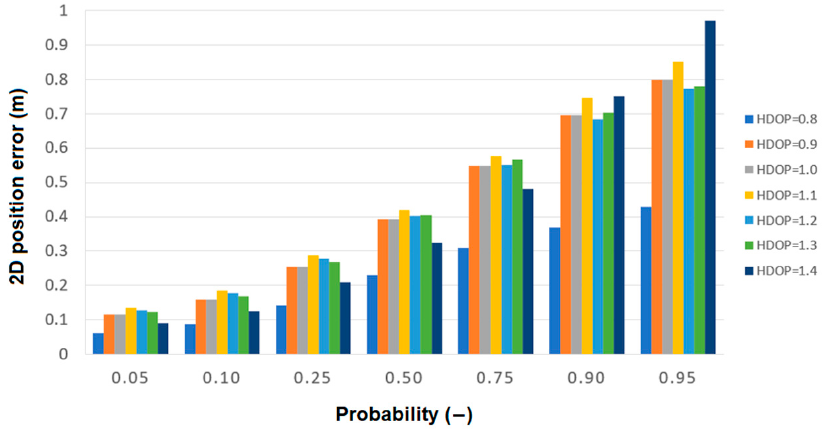
Figure 7. The DGPS system’s accuracy ( Y axis) as a function of the HDOP value at a varying prob-